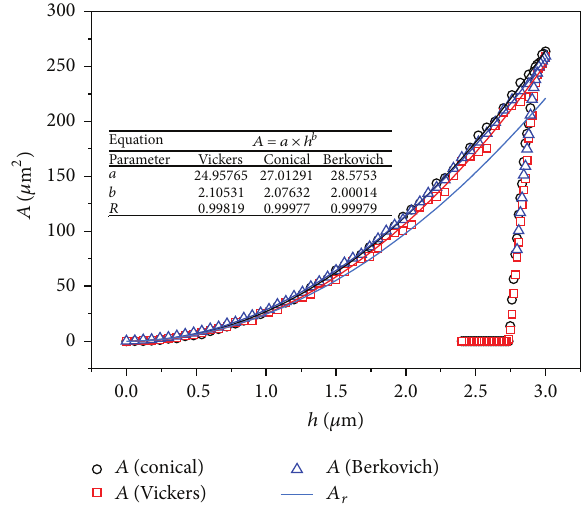
Figure 4: True projected area-displacement curves for three kinds of indenters. 𝐴 𝑟 is the reference area that is calculated from the indentation depth by using the area function of the indenters. The solid lines are the power law fitting of the loading parts. 𝐸 = 100 GPa, 𝑌 = 800 MPa.